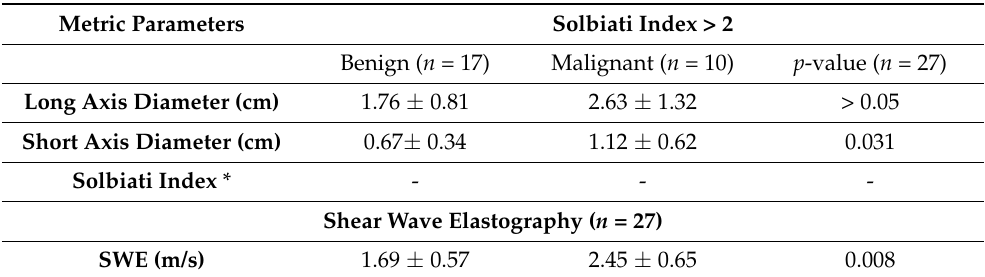
Table 3. Analysis of subgroup “Solbiati Index > 2”. All metric variables are given as mean with corresponding standard deviation. Abbreviations: SWE, shear wave